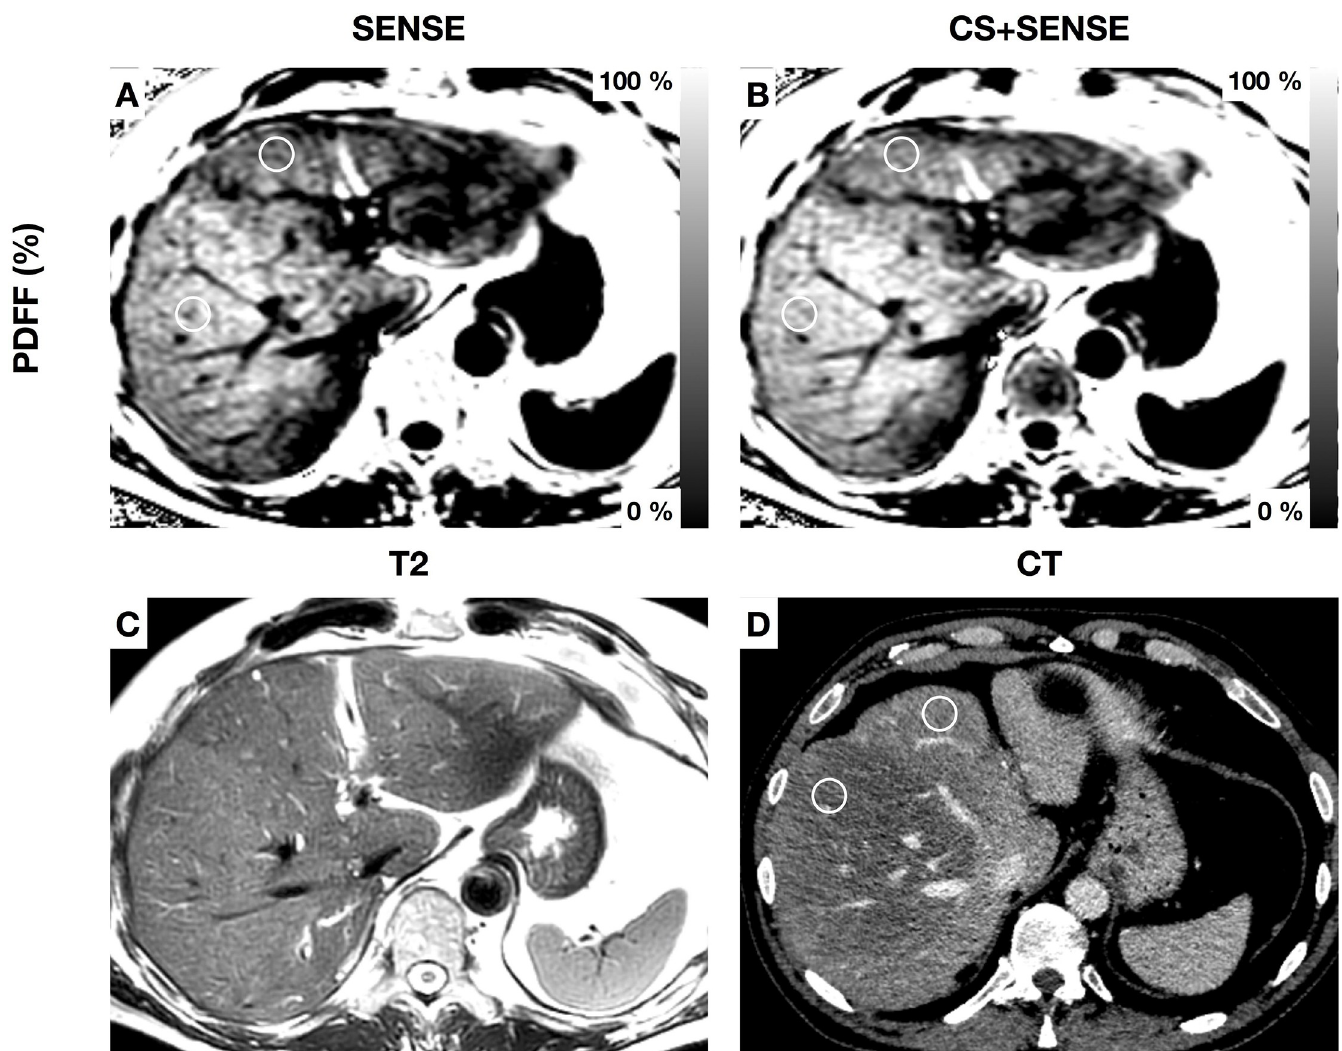
Fig 3. Patient with segmental hepatic steatosis. Exemplary regions of interest are drawn in segments IVa and V (diameter 1.5cm). PDFF Segment IVa: acquisition with SENSE 25.7 ± 1.5% (A); acquisition with CS+SENSE 26.9 ± 2.0% (B) PDFF Segment V: acquisition with SENSE 31.6 ± 1.8% (A); acquisition with CS+ SENSE 32.6 ± 2.2 (B) A T2-weighted image (C) and a CT image in the venous contrast phase (D) are shown for comparison. In CT Hounsfield units are 87 ± 13 in Segment IVa and 42 ± 16 in Segment V.